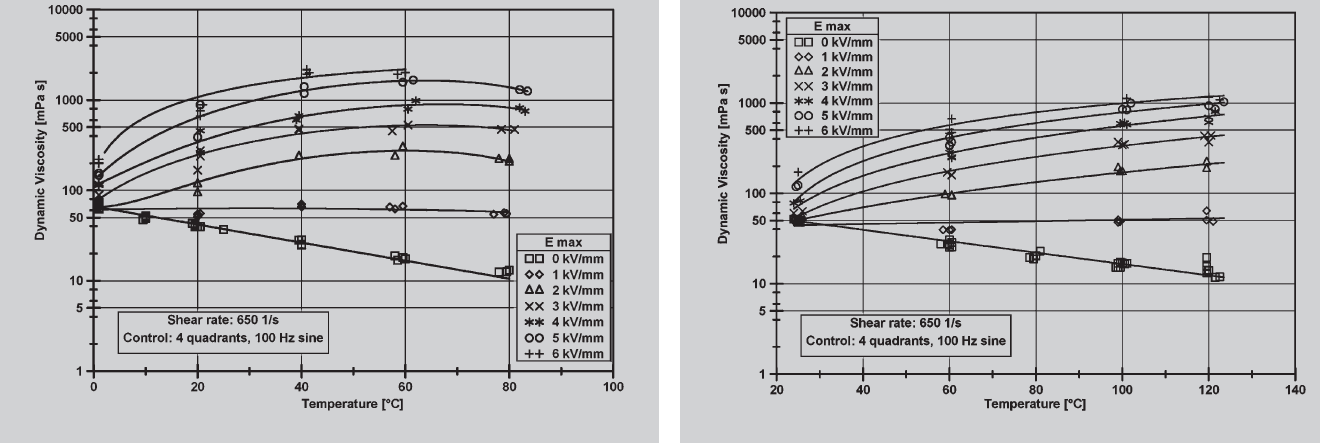
Figure 4 (left): V-T behavior of suspension A (Li + doped) exposed to the electric field [3]. Figure 5: V-T behavior of suspension B (Zn 2+ doped) exposed to the electric field